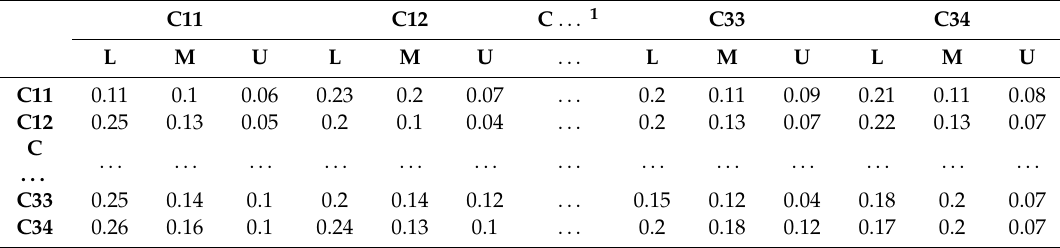
Table 7. Total fuzzy relation matrix for performance